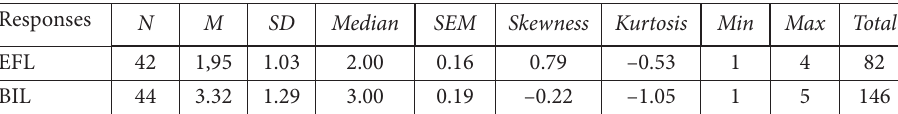
Table 7. Descriptive statistics of the scale items G – originality contribution for English as foreign language (EFL) and bilingual (BIL) groups (source: created by authors) Responses